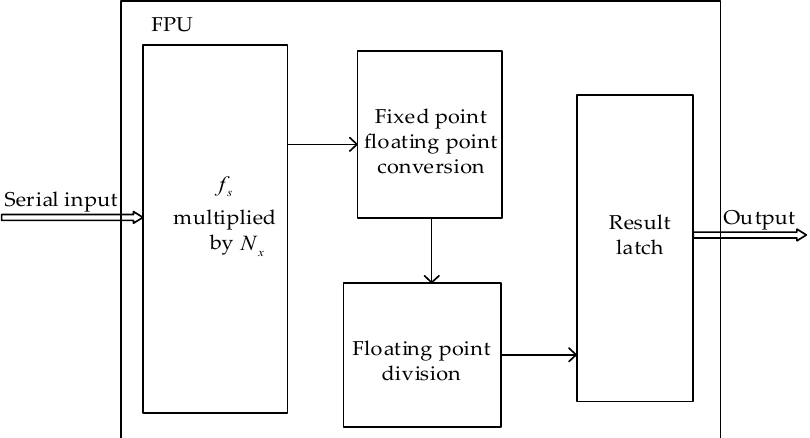
Figure 7 . Floating point calculation process. Figure 7. Floating point calculation